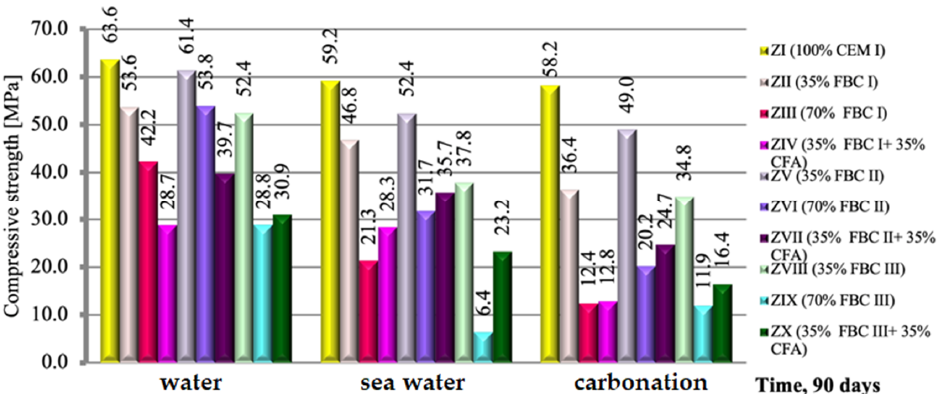
Figure 10. The compressive strength of mortars containing fluidized bed combustion fly ashes of different origins and mixtures of FBC and conventional fly ashes, cured in tap water, seawater and the carbonation process. (Expanded un- certainty of measurement for flexural strength equals: in water ±0.69; sea water ±0.87; carbonation ±1.0